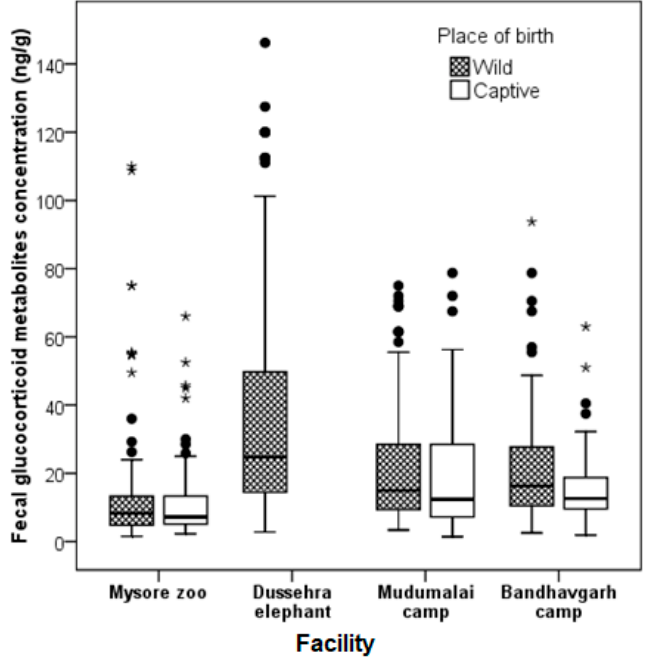
Figure 1. Box plot showing fGCM concentrations of elephants born in captive and the wild in four elephant facilities. In the Dusshera camp, all the elephants were wild caught (Filled rounds = outliers, filled asterisk = extreme values).